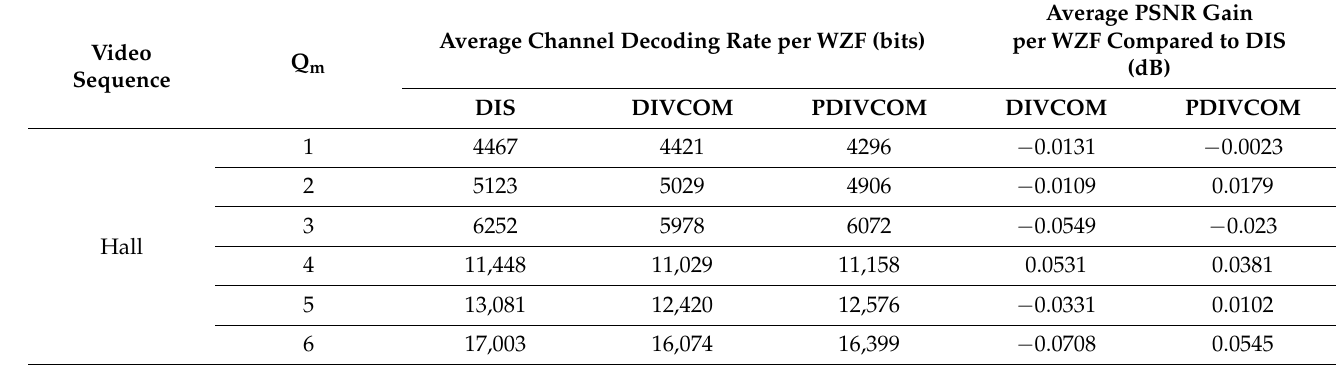
Table 9. Coding efficiency evaluation of proposed novel online CNM for “Hall” video sequence.